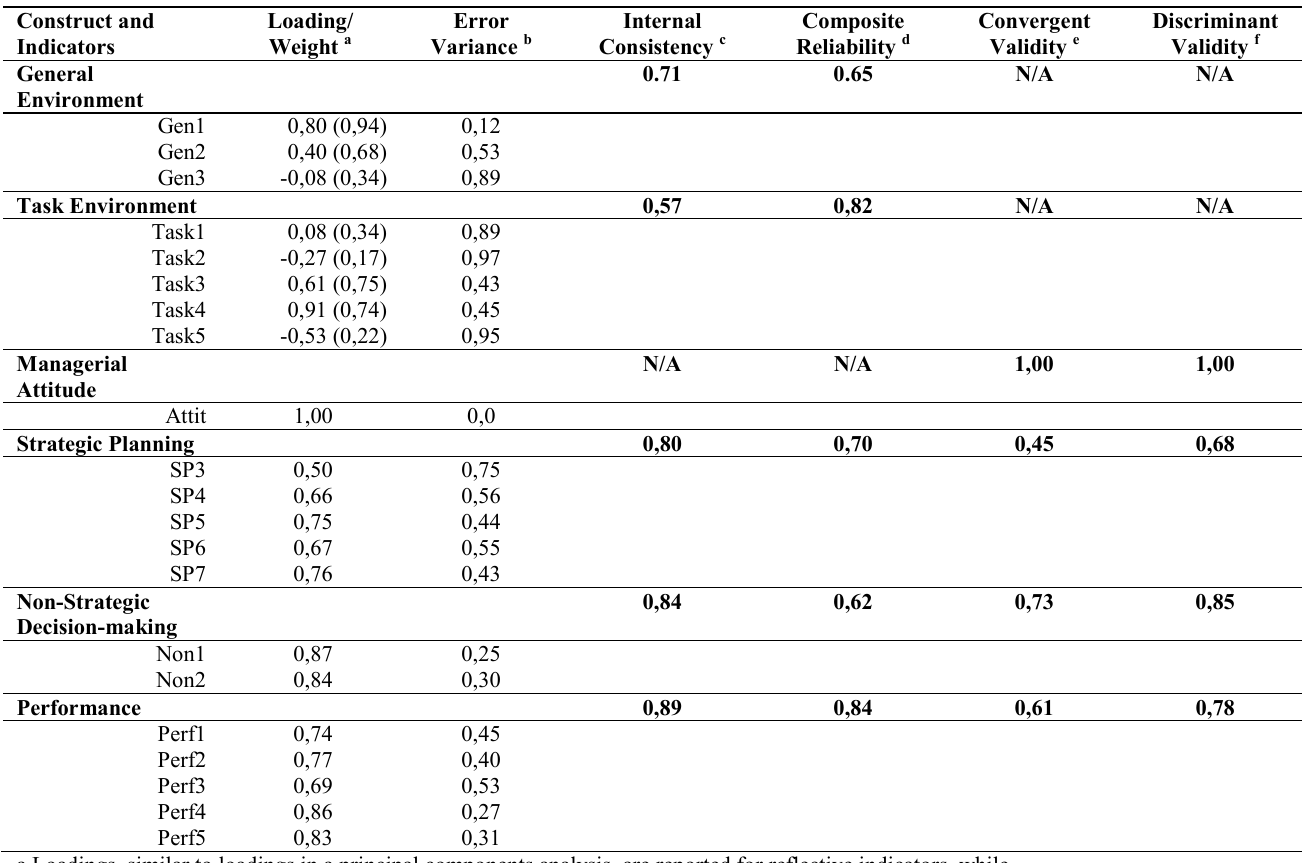
Table 4: Tests of the measurement model Construct